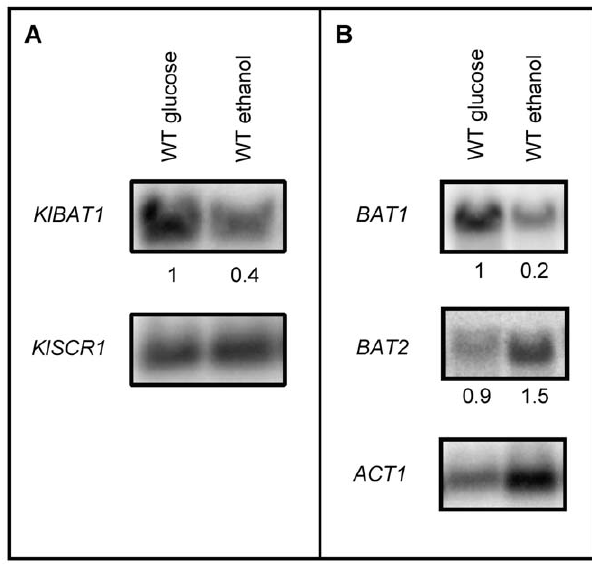
Figure 6. BAT1 and KlBAT1 expression is repressed under respiratory conditions. Northern analysis was carried out with total RNA samples obtained from S. cerevisiae WT, bat1 D BAT2 and BAT1 bat2 D and K. lactis WT cultures grown on ammonium-glucose or ammonium-ethanol to mid exponential growth phase. Filters were sequentially probed with the BAT1 , BAT2 , KlBAT1 - specific PCR products described in experimental procedures and a Bam H1- Hind III 1500 bp ACT1 DNA or an SCR1 400bp PCR fragment as loading controls. Numbers indicate relative expression as compared to the WT strains grown on ammonium-glucose. Four biological replicates were per- formed, and representative results are shown. doi:10.1371/journal.pone.0016099.g006 PLoS ONE |